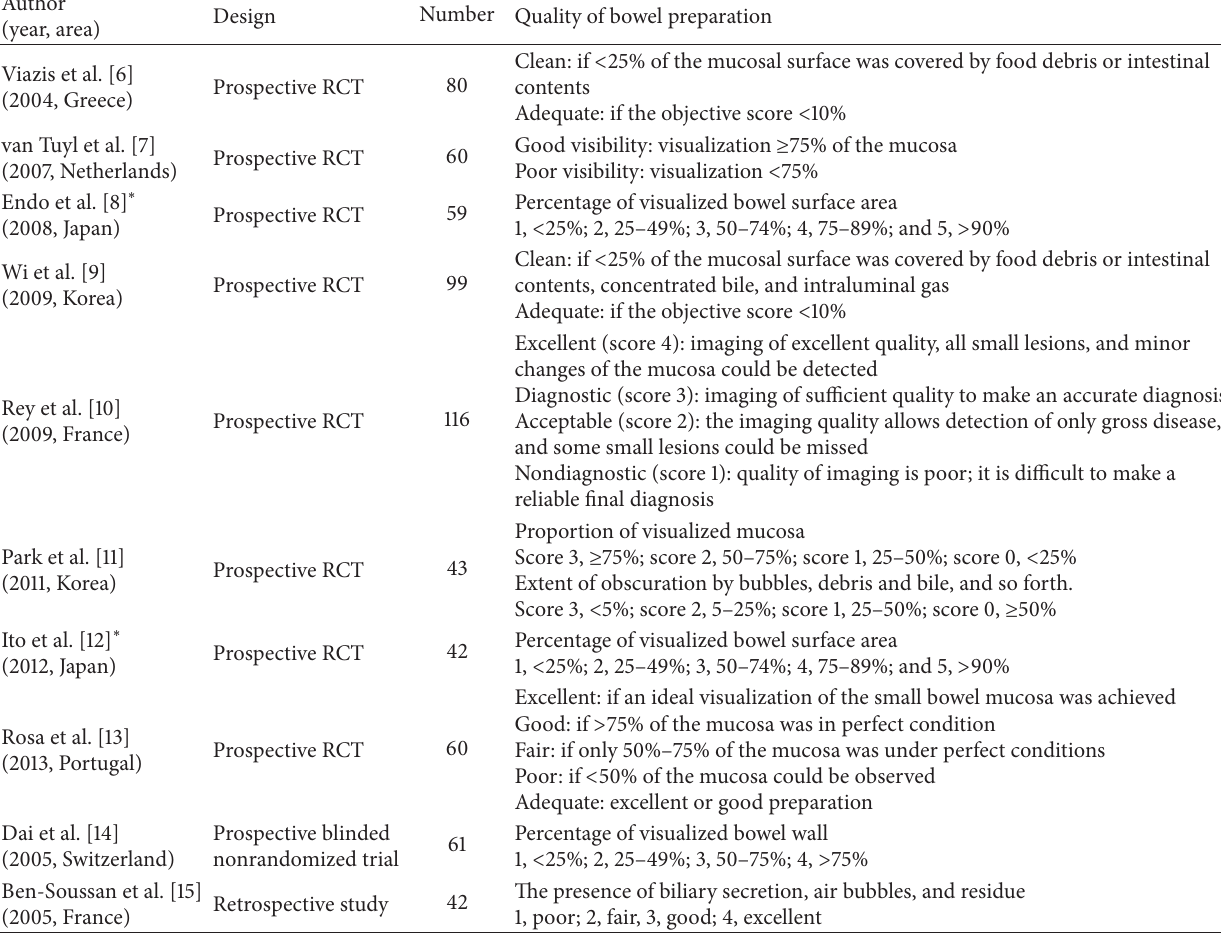
Table 3: Definitions of optimal bowel preparation of VCE among studies with